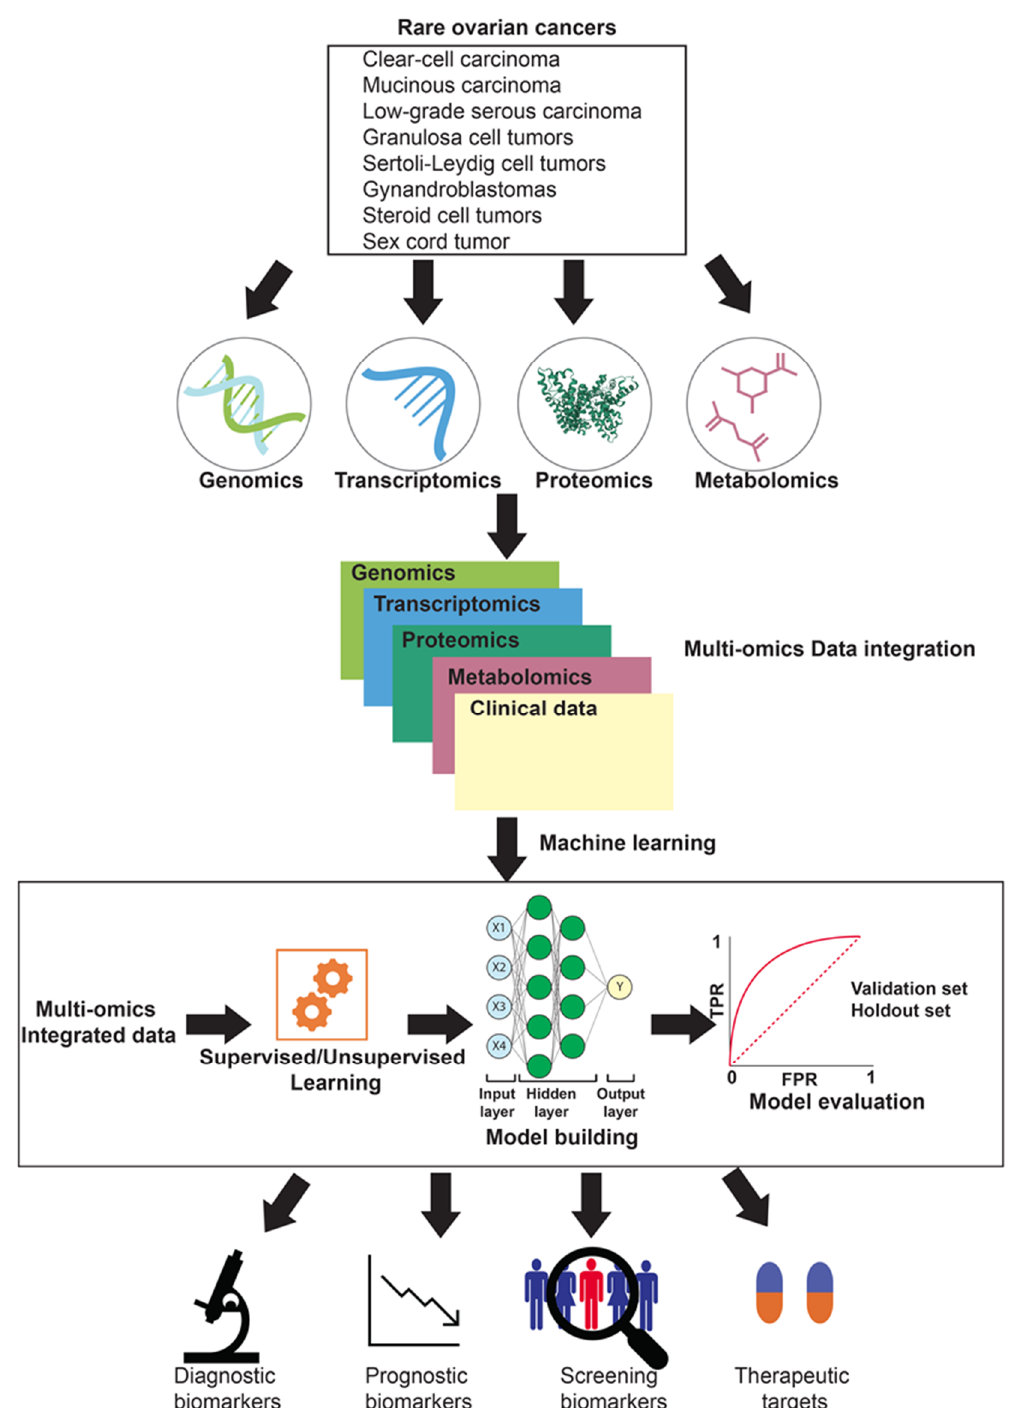
Figure 1. An overview of the various omics approaches for the characterization of rare ovarian cancers and their potential applications. Multiple omics approaches, including genomics, transcriptomics, proteomics, and metabolomics, can be employed to study rare ovarian cancers. Omics datasets from these approaches could be then integrated. The integrated data could then be analyzed using machine learning algorithms to identify diagnostic biomarkers, prognostic biomarkers, screening biomarkers, and therapeutic